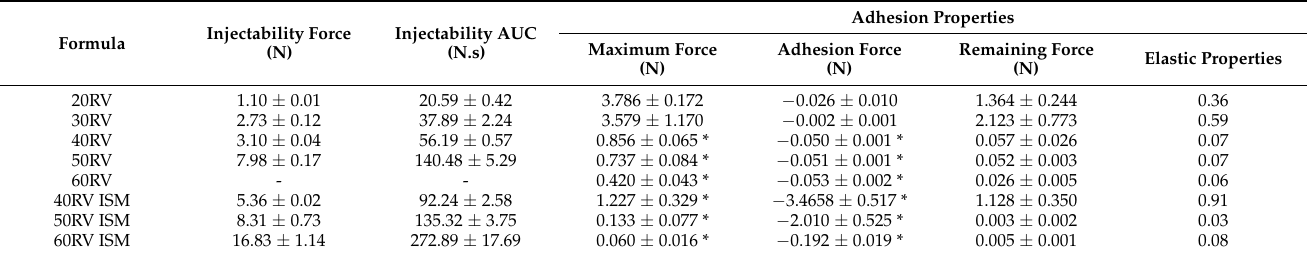
Table 3. Force and AUC of injectability, and adhesion properties of the vancomycin HCl-loaded rosin-based ISG and ISM formulations ( n =